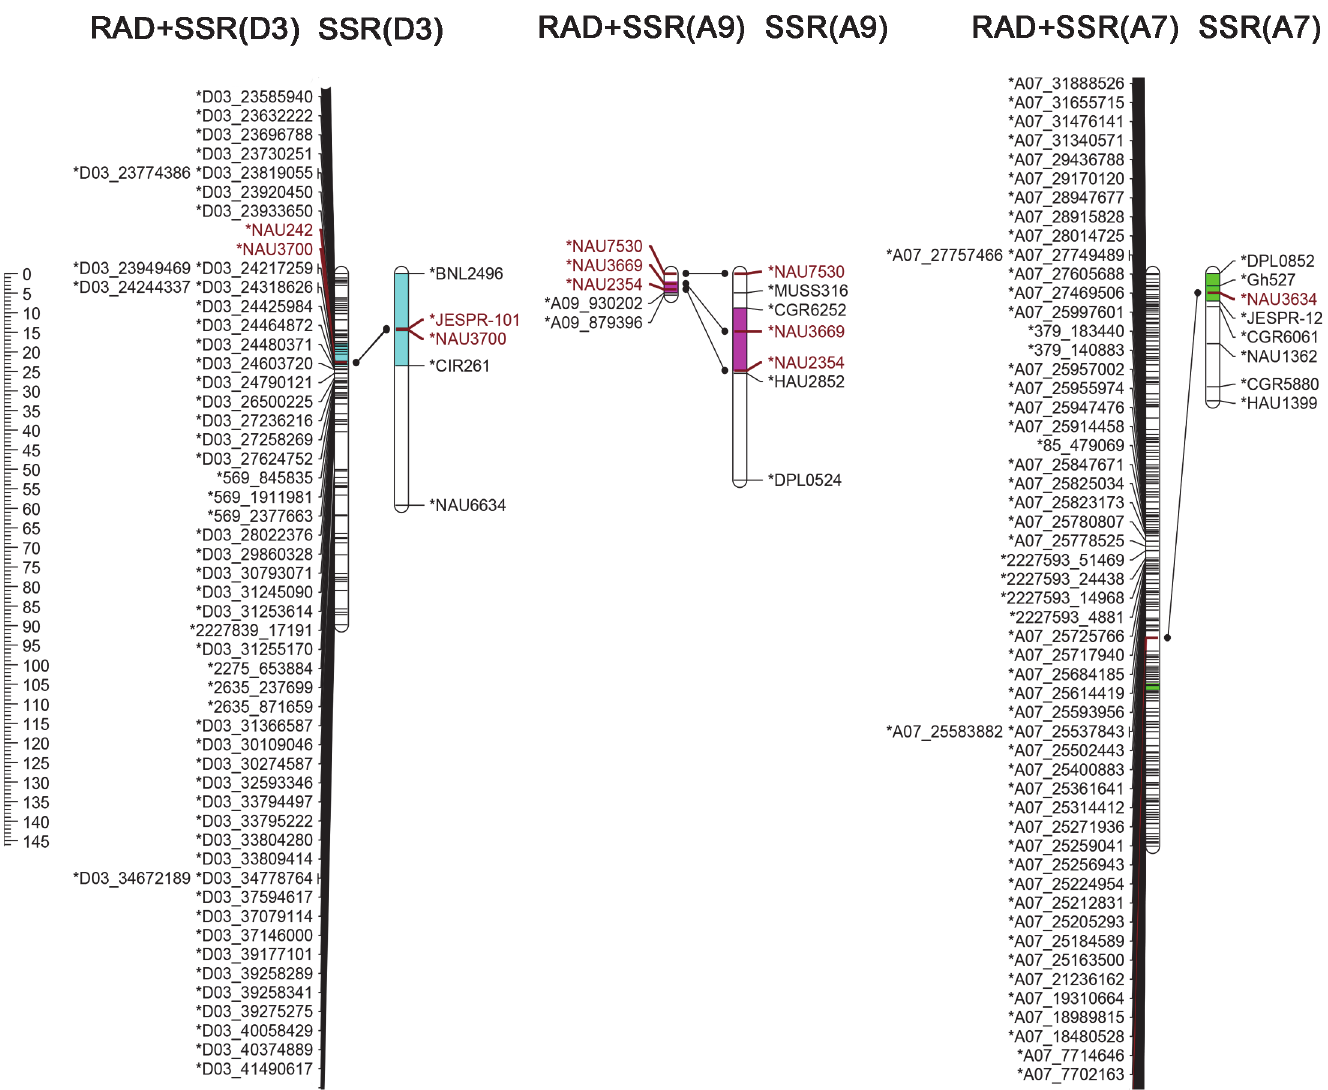
Fig 2. QTLs for fiber strength in two maps. Three QTLs for fiber strength, qFS-D3-1 , qFS-A9-1 , qFS-A7-1 were identified on both maps, with the different colors indicating different 2-LOD intervals for each QTL. Maps were constructed with RAD markers plus SSR markers, and with SSR markers alone. Lines connecting the same markers in these two maps correlated the trait: these markers are colored